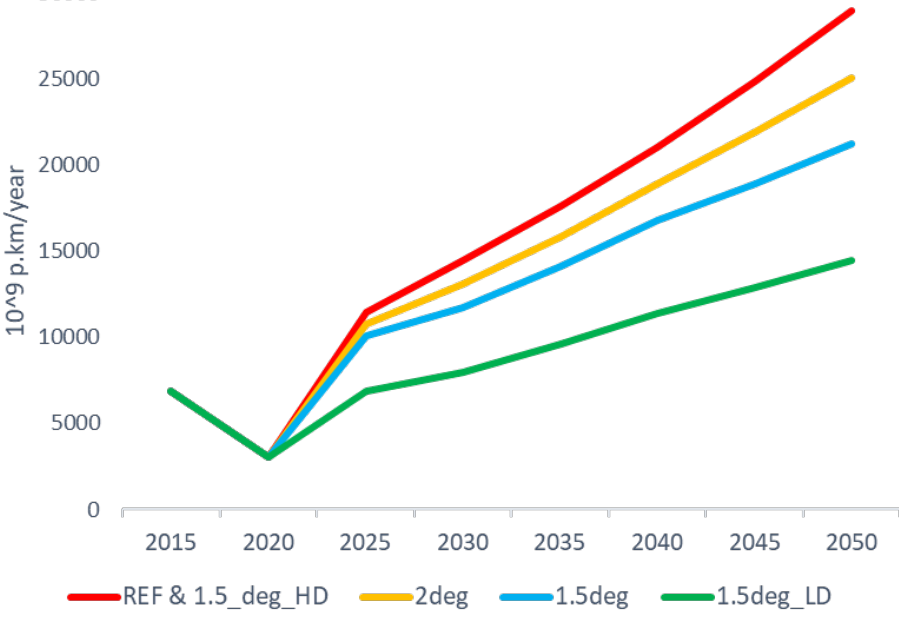
Figure 4. Global aviation activity in the series of scenarios over 2015 – 2050.